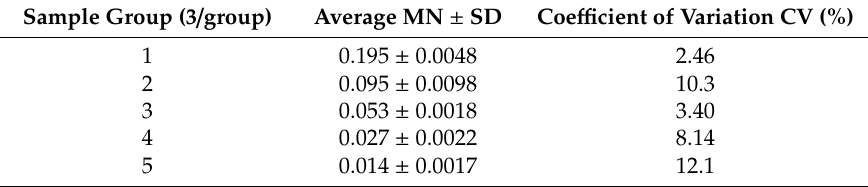
Figure 6. Fluorescence picture of CPA detection and the established standard regression equation. ( a ) Fluorescence pictures at di ff erent toxin concentrations: from left to right concentrations are 10LD 50 , 5LD 50 , 2.5LD 50 , 1.25LD 50 , 0.625LD 50 ; ( b ) Standard regression equation based on fluorescence intensity and toxin concentration, Y = 0.01915X + 0.002875 (R 2 = 0.9972). Scale bar = 50 µ m. Table 2. Repeatability test for fluorescence detection of silica microspheres ( n = 3). Sample Group (3 /